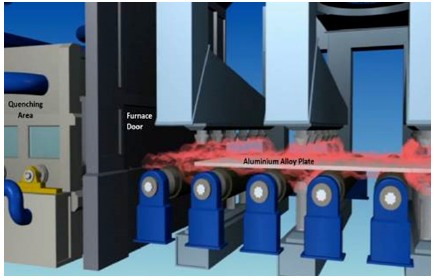
Figure 4. The plate is in the furnace. Figure 5. The furnace door is opened and the plate is ready to enter in the quenching